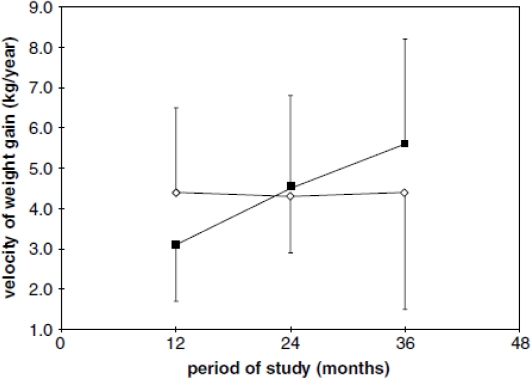
Rate of weight gain/y (mean7s.d.) over the follow-up time (nonstunted ⋄; stunted ▪). ANOVA: group factor (F (1.24) = 0.01; P = NS), time factor (F (2.48) = 3.99; P = 0.02), and interaction factor (F (2.48) = 3.99; P = 0.002). Reprinted with permission from Eur. J. Clin. Nutr. [45].